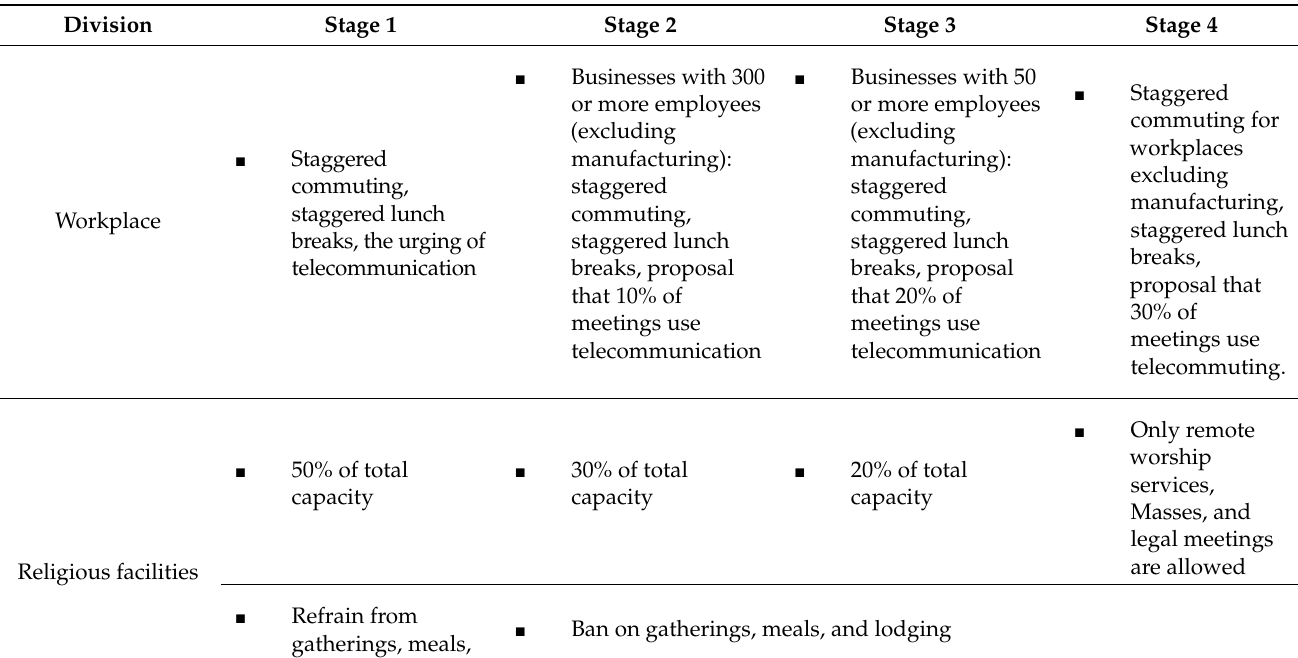
Table 1. Step-by-step quarantine rules for vulnerable facilities (Ministry of Health and Welfare 2021a). Division